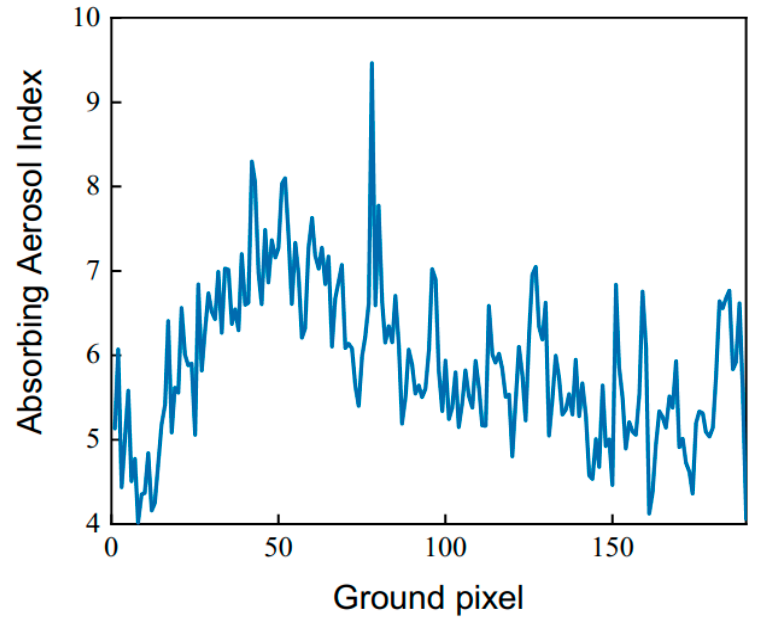
Figure 2. Variation of the AAI with ground pixel.